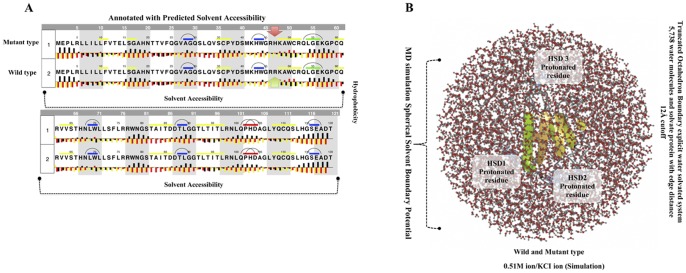
Evaluation of the secondary structures of the TREM2 domain and MD simulation in solvated protein.Values of median pho (black bars) and phi (yellow bars) ASA for each residue in the extended state (A) with residues sorted according to decreasing total ASA values. Median hydrophilic solvent accessibility as a function of median hydrophobic solvent accessibility of residues was in most of the loop regions. Residues of wild type Arg47 (R) (green) and mutant His (H) (red) are upstream outside of this classification. The distribution of total a solvent accessibility for wild type and mutant (Arg ⇒His47) residues. The values of the median and mean total solvent accessibility are indicated for each of these residues. B) The MD simulations used in the calculations included a water box surrounding the entire protein (middle) and the tertiary structure of the wild type TREM2 protein domain showing triple risk associated mutations, i.e., Arg ⇒His47 (R→H) on β sheet4 is shown in green. The visual inspection also allowed us to identify the side chain of a histidine residue involved in the hydrogen bonding with surrounding molecules and, in that case, the δ nitrogen of the histidine (HSD1-3) was a protonated residue.